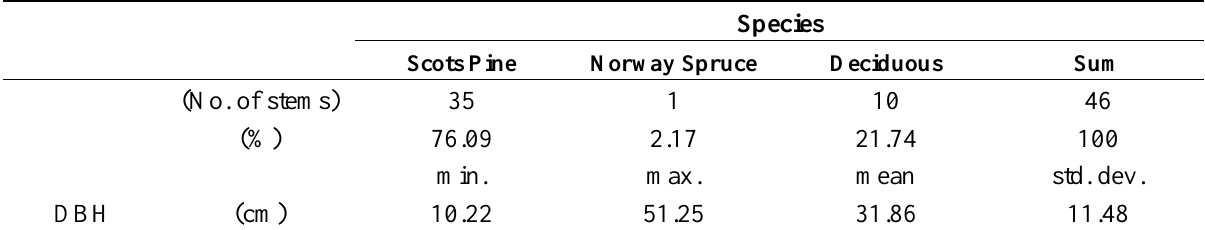
Table 3. Descriptive statistics of the trees in the study